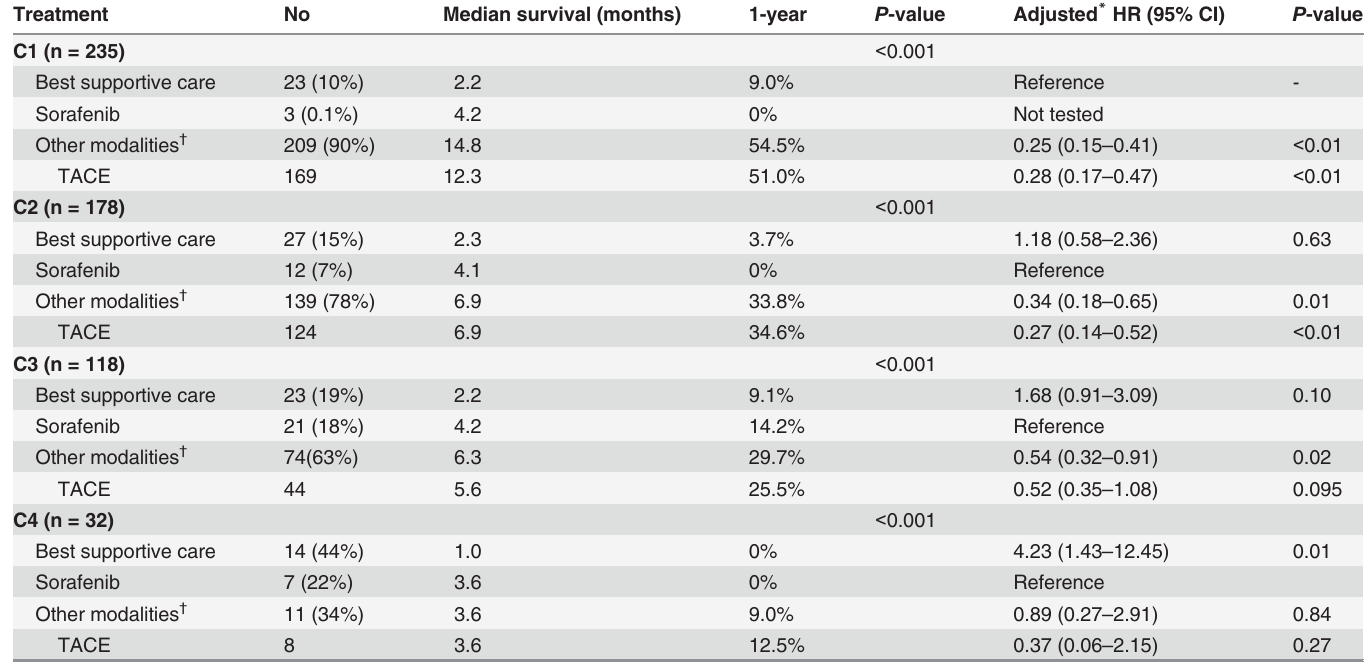
Table 5. Survival by treatment modalities in each sub-stage.